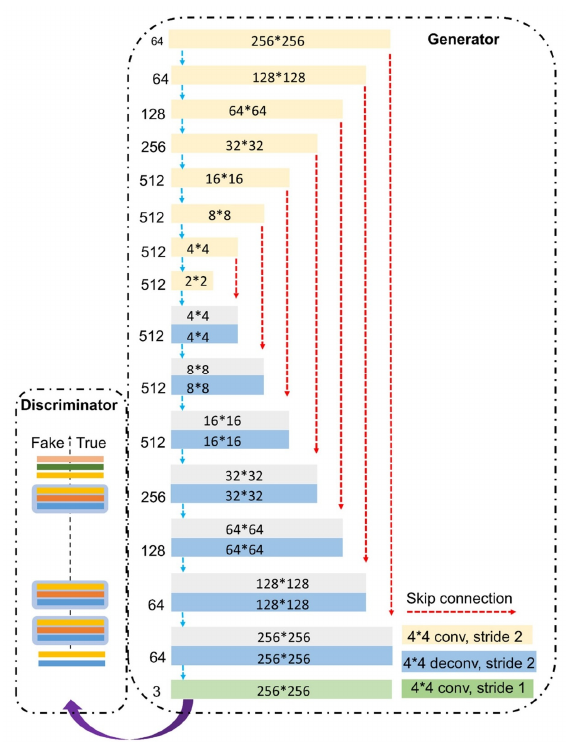
Figure 5 Deep learning virtually colorizing based on a GAN architecture [57]. Figure 5. Deep learning virtually colorizing based on a GAN architecture